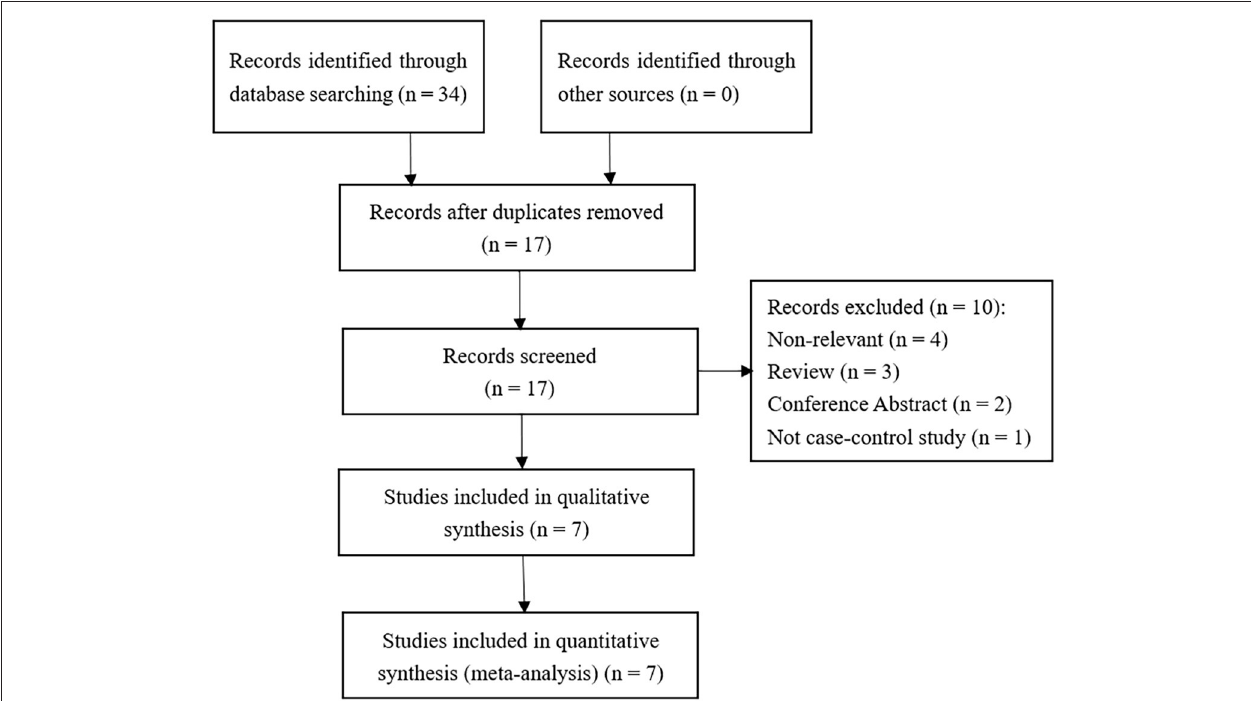
FIGURE 1 | Flow diagram for study